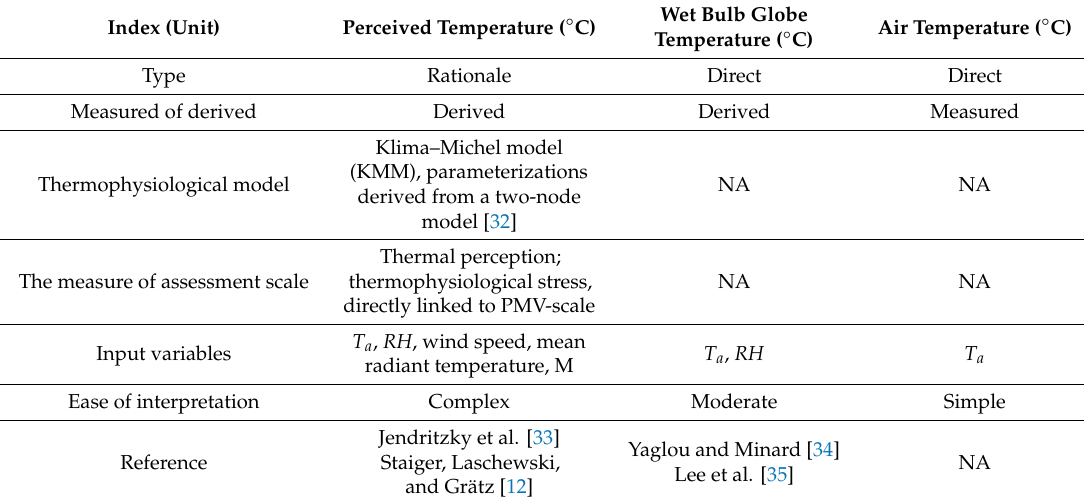
Table 1. Information of the employed temperature